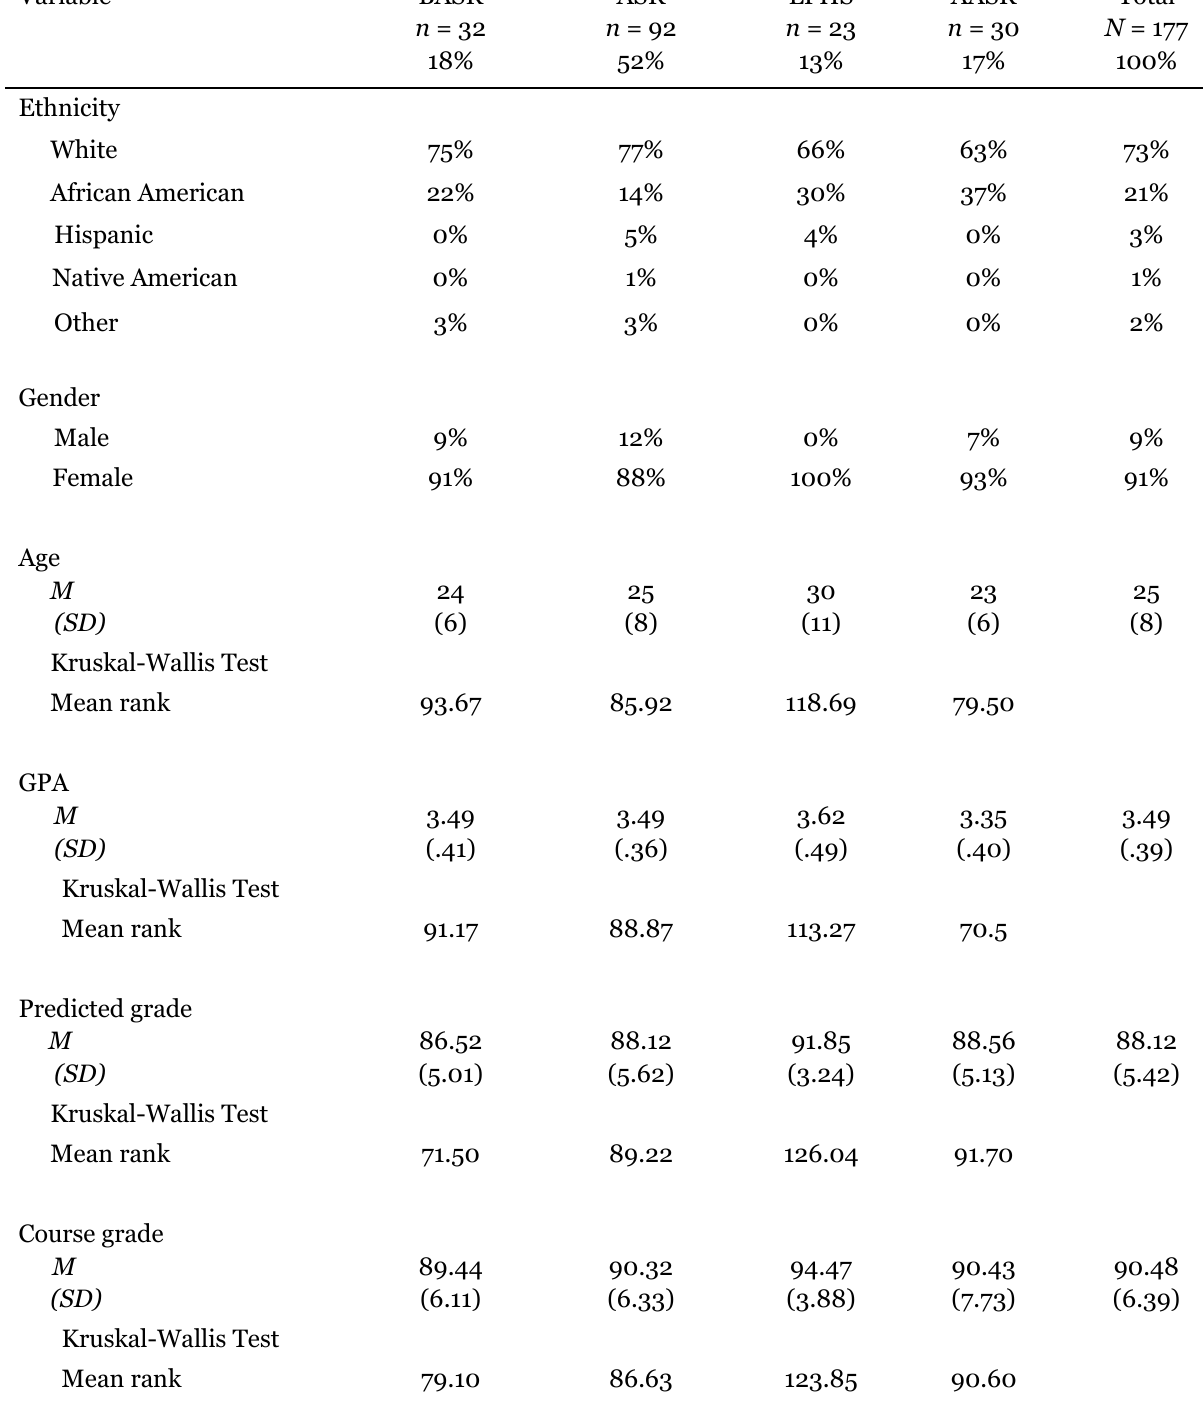
Table 7 Demographics and Student Achievement by Latent Profile